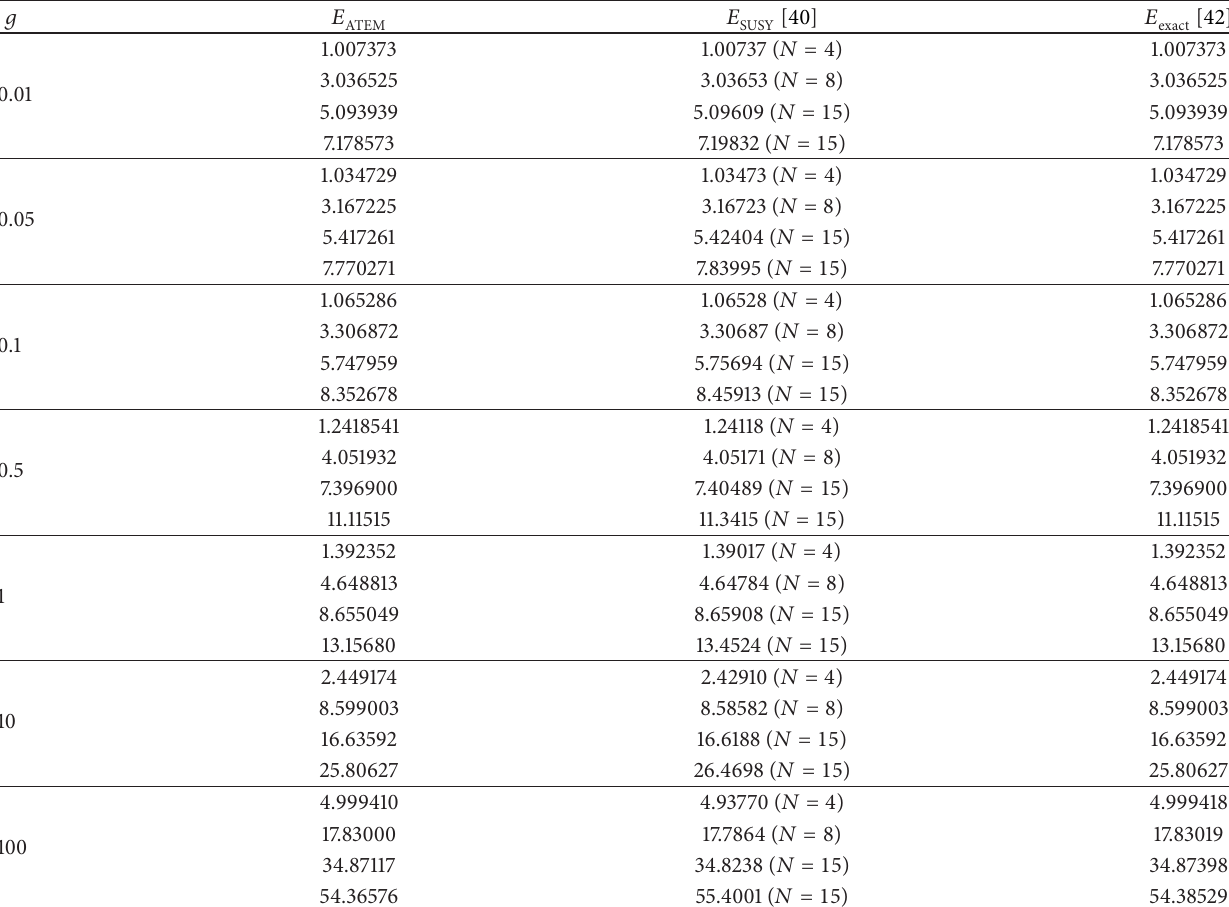
Table 1: Eigenvalues of the potential in (15) for a range of 𝑔 values. For ATEM results, number of iterations for each 𝑔 value is set to 120 . For SUSY results, numbers in parenthesis ( 𝑁 ) denote the perturbation order used by authors in [40].